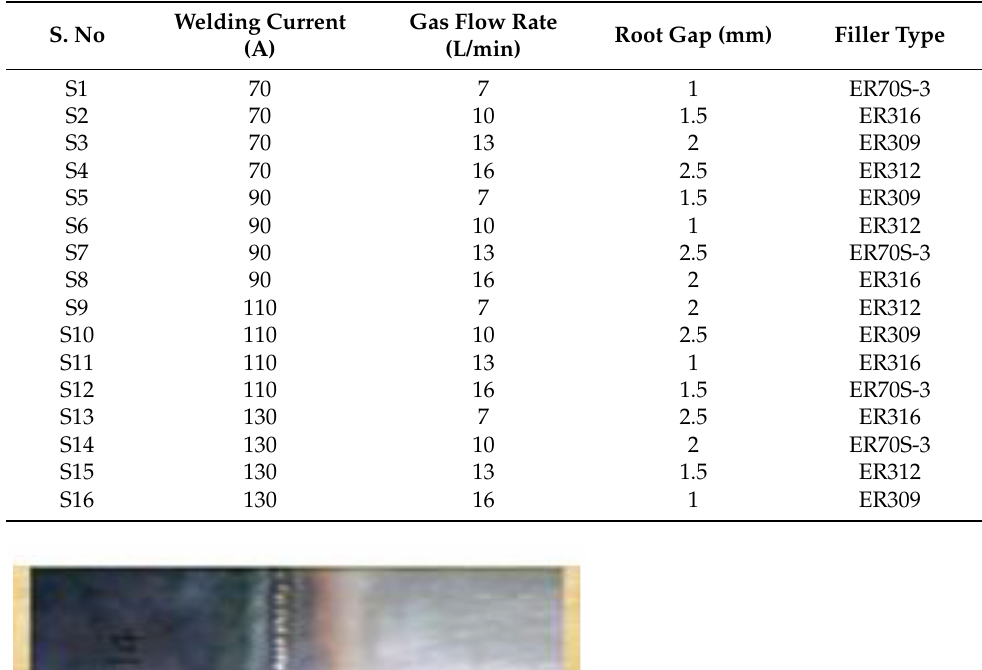
Table 4. Experimental plan for similar and dissimilar metals, L16 OA.